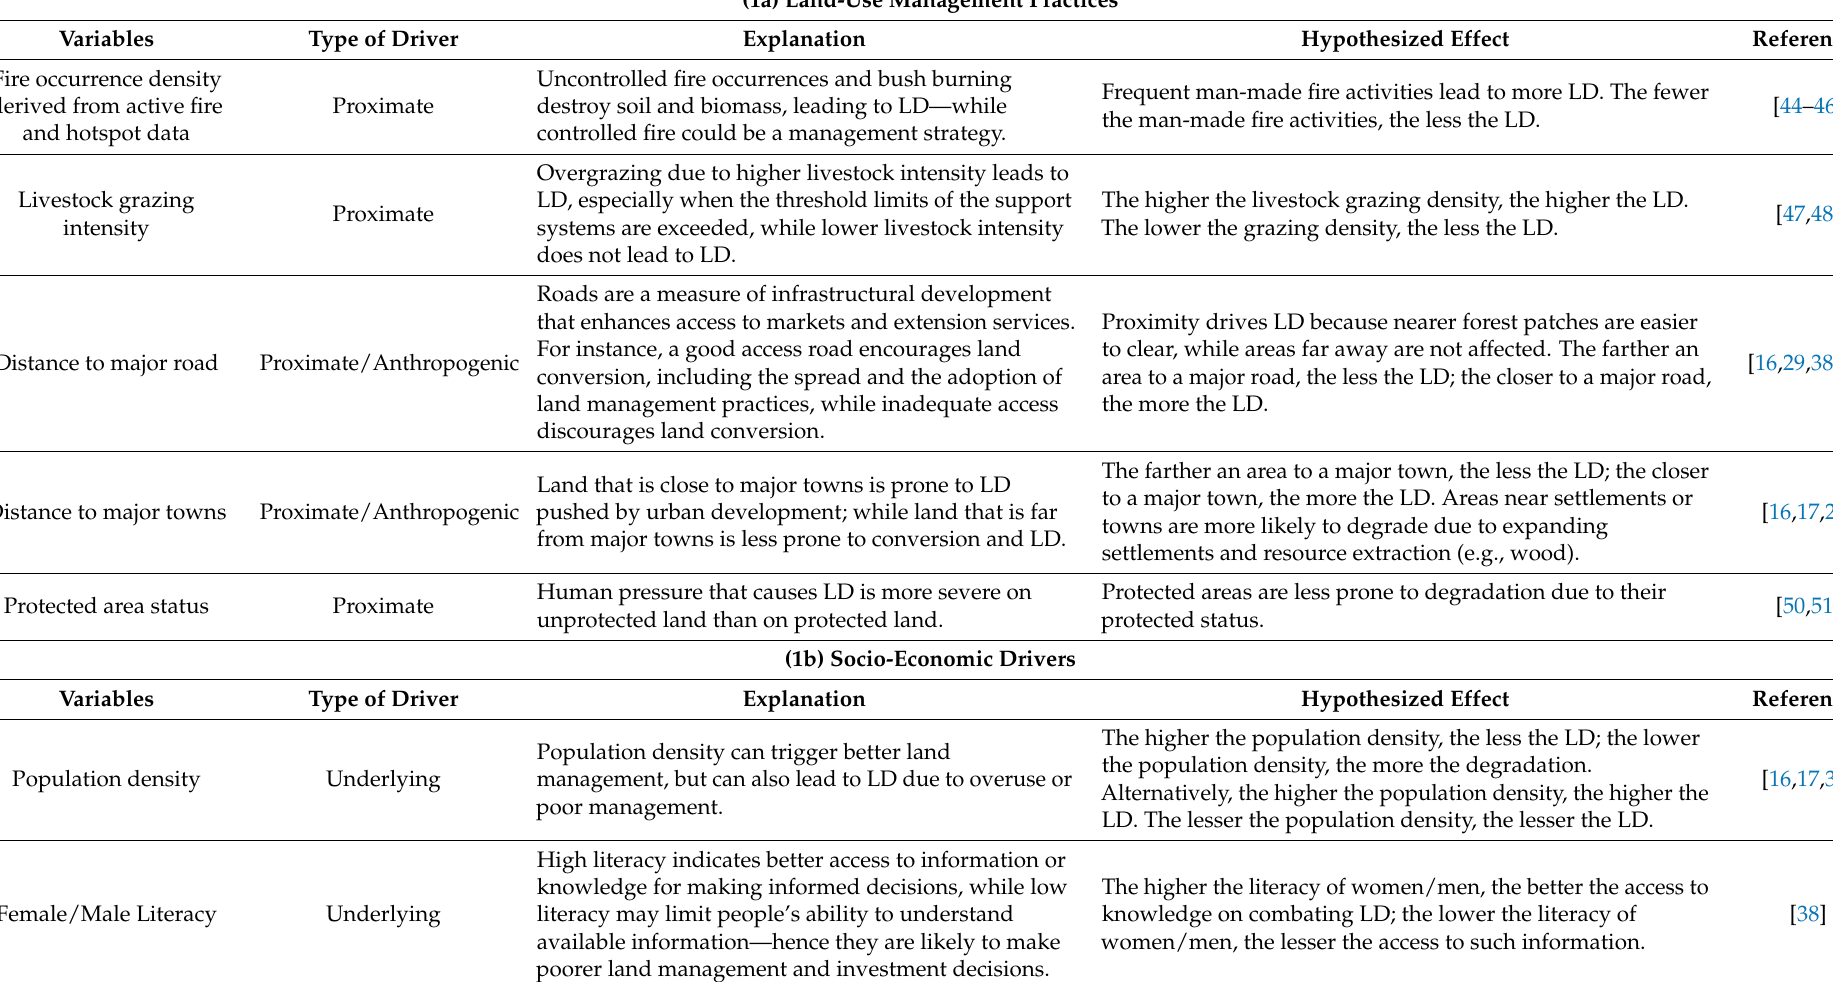
Table 1. List of driver’s datasets for the development of